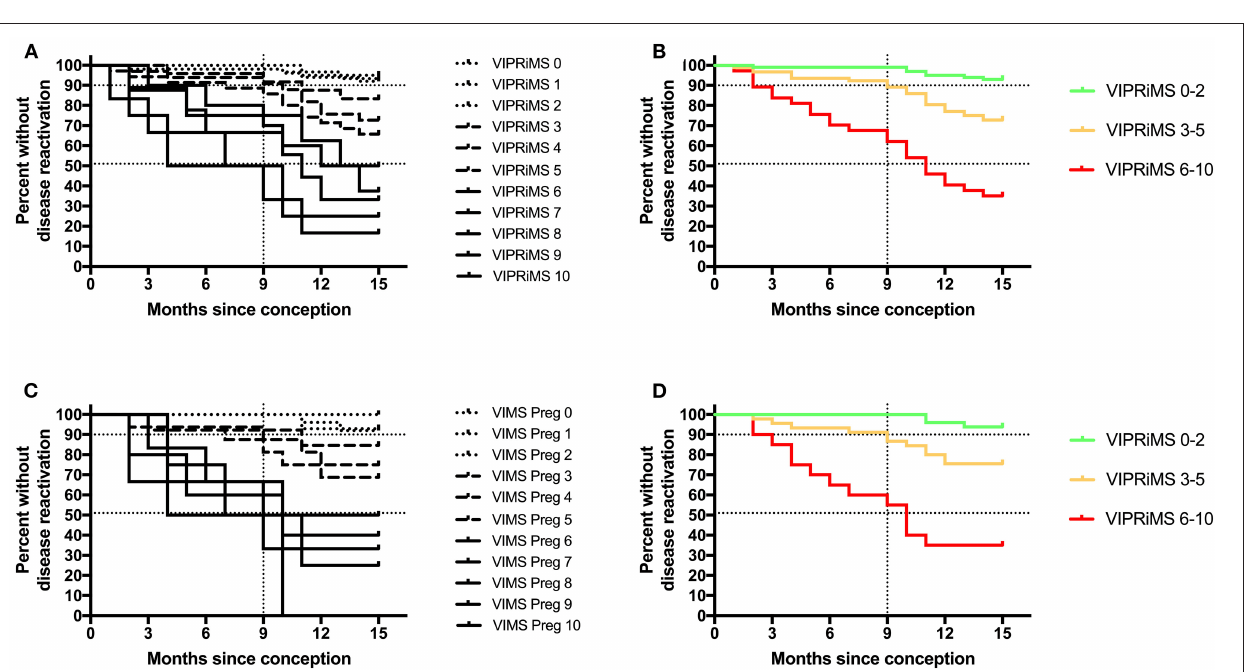
FIGURE 2 | Probability of clinical disease reactivation in and after pregnancy stratified according to the Vienna Innsbruck Pregnancy Risk in Multiple Sclerosis (VIPRiMS) score in the generation cohort (A,B) and in the validation cohort (C,D) . Vertical dotted line marks the timepoint of delivery. Horizontal dotted lines indicate the 10th and 50th percentile of probability of clinical disease reactivation. Groups significantly differed in all the four graphs ( p < 0.001, calculated by log-rank test for